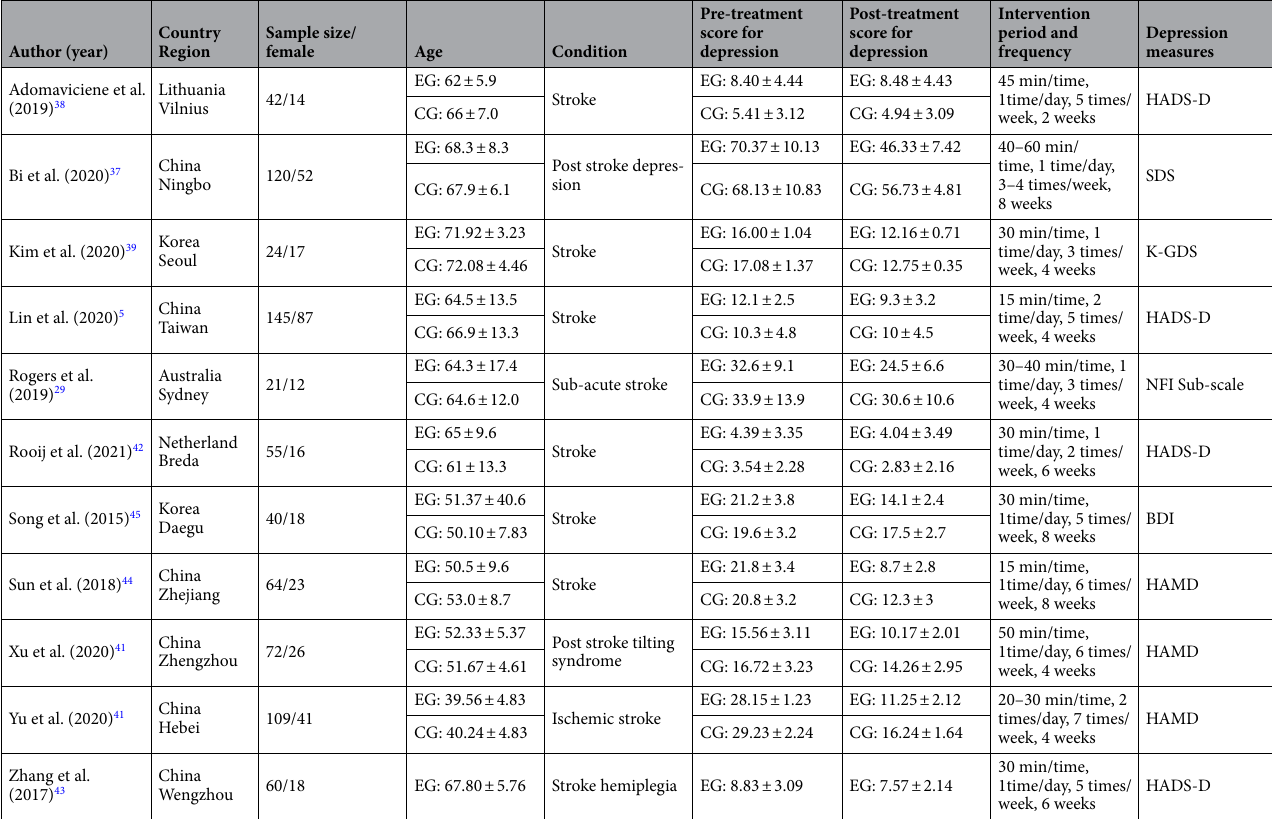
Table 1. Characteristics of the studies included the meta-analysis. EG experimental group, CG control group, HADS-D hospital anxiety and depression scale for depression, SDS self-rating depression scale,